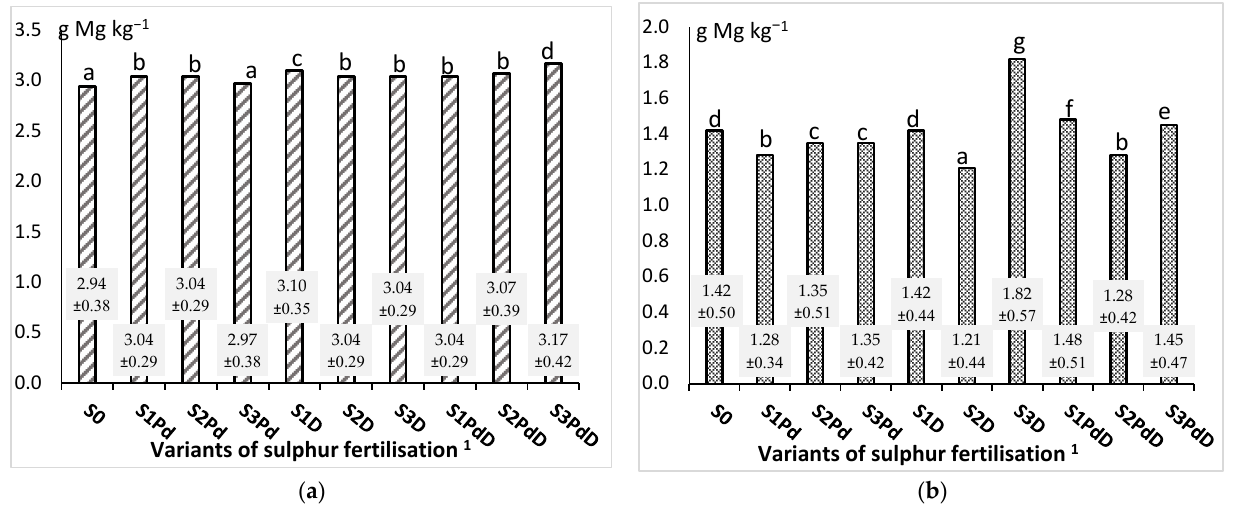
Figure 11. ( a ) Magnesium content in the rape seeds on average for variants of sulphur fertilisation; ( b ) Magnesium content in the rape straw on average for variants of sulphur fertilisation. 1 See Table 2; Means followed by the same letter are not statistically different at the α = 0.05 level. ± —standard deviation.